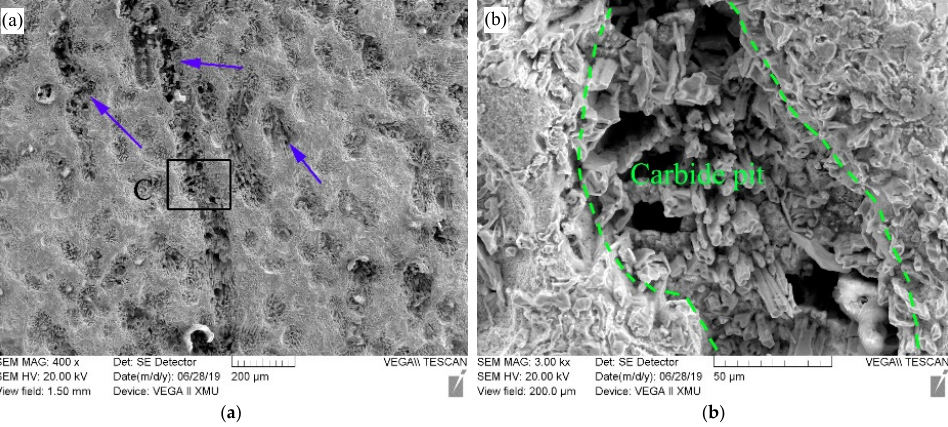
Figure 8. Erosion–corrosion face morphology SEM of boron-bearing stainless steel sample under test condition of rotating speed 1700 rev·min − 1 : impingement angles contain 0° ( a ), 45° ( b ) and 60° ( d ); ( c ) displaying the magnified microstructures of B area.